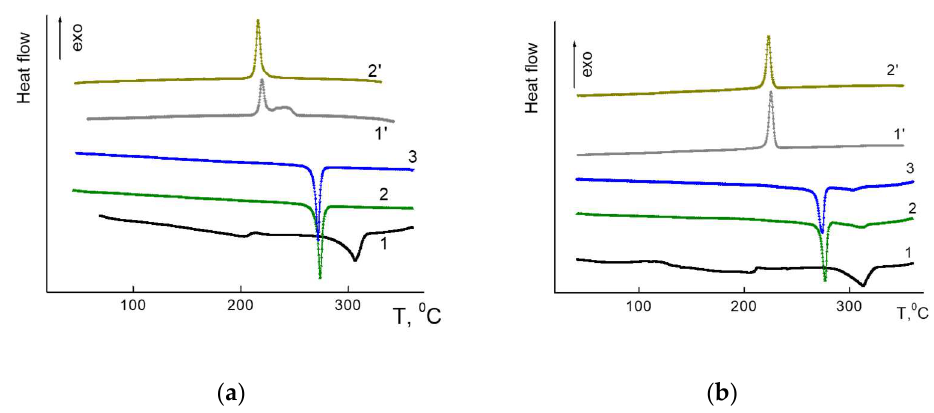
Figure 2. DSC traces for the first, second and third heating–cooling cycles for G1 ( a ) and G2 ( b ). Table 1. Parameters of the phase behavior of dendrimers in heating–cooling cycles.